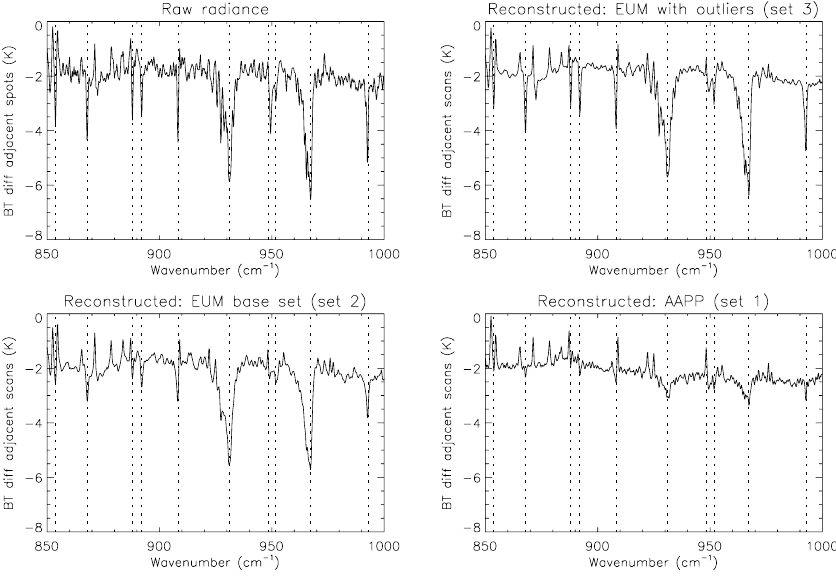
Fig. 2. Difference spectra between a spot on the northern edge of the plume and a spot on the following IASI scan line which is outside the plume. Vertical dotted lines mark the positions of ammonia absorption lines, from Clarisse et al. (2008b).